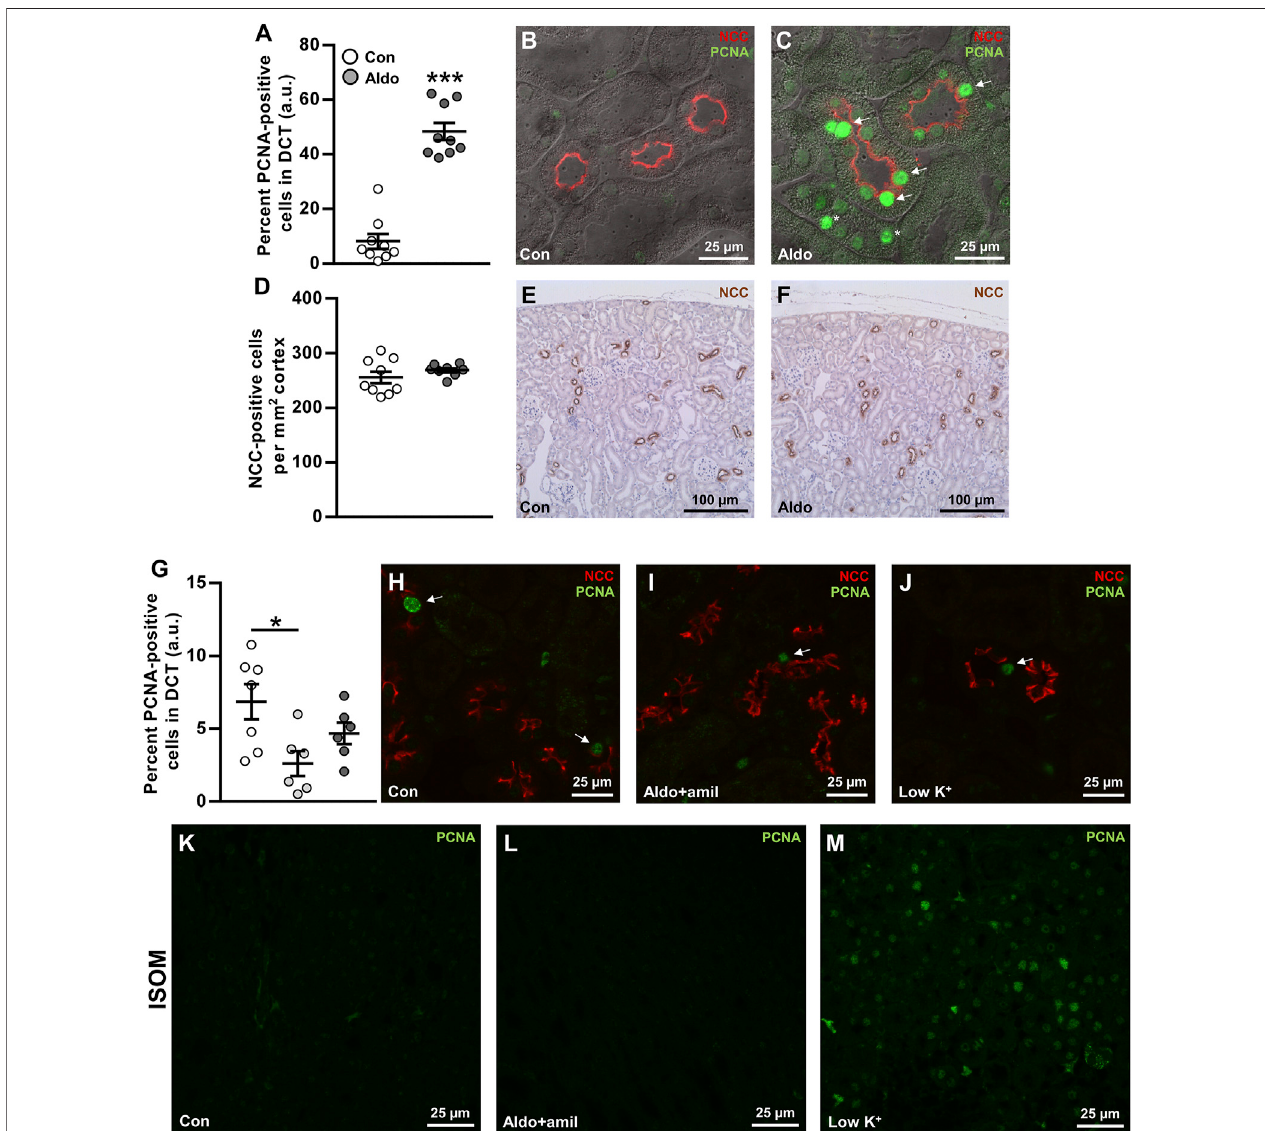
FIGURE5| Aldosteroneinfusionfor6 daysincreasedtheproliferationmarkerPCNAinrenalDCT. (A – C) ThepercentPCNA-positivecellsintheDCTwasmarkedly increased by 6 days aldosterone infusion. Arrows indicate PCNA in DCT cells. Asterisks indicate PCNA in non-DCT cells. (D – F) The numbers of DCT cells/mm 2 cortex were not changed signi fi cantly by 6 days aldosterone infusion. (G – J) Amiloride + aldosterone infusion for 6 days reduced the number of PCNA-positive DCT cells, whereas no signi fi cant effect was found in mice fed a low K + diet for 6 days. Arrows indicate PCNA in DCT cells. (K – M) In the inner stripe of the outer medulla (ISOM), qualitative assessment showed greater PCNA labeling in mice fed a low K + diet whereas no clear effect was observed in the mice infused with amiloride + aldosterone. Kidney tissue in panel (A – F) originated from a previously published study (Poulsen and Christensen, 2017). Data are presented as dot plots and mean ± SEM. n = 9 [control and aldosterone (A – F) ], n = 7 [control (G – M) ] or n = 6 [amiloride + aldosterone and low K + (G – M) ]. Statistical comparisons were performed using Satterthwaite ’ s 2-tailed unequal variance t -test (A,D) or a one-way ANOVA followed by post-hoc testing with FDR-correction (G) . * p < 0.05, *** p < 0.001.